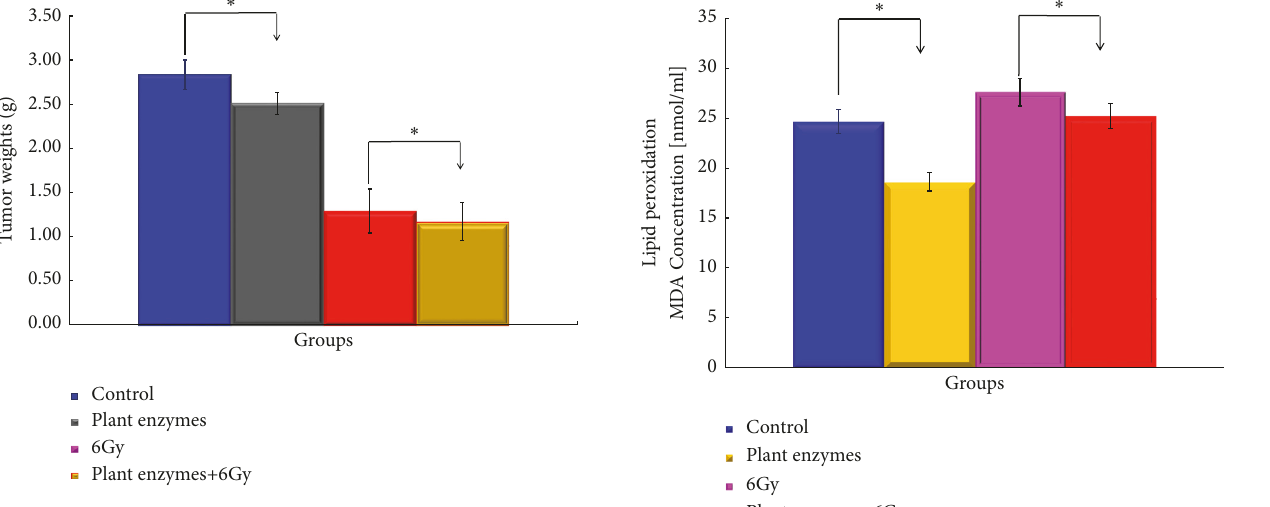
Figure 2: Effect of Validux Plant Enzyme on the tumor weight in mice inoculated with 4T1 (high grade) of mouse prostate cancer cell line. Groups of ten mice each were subjected to each treatment. Results represent means ± SD for 7-8 mice. ∗ Significantly different from the Validux Plant Enzyme vs. control group and Validux Plant Enzyme +6Gy vs. 6Gy ( P < 0.05 ).